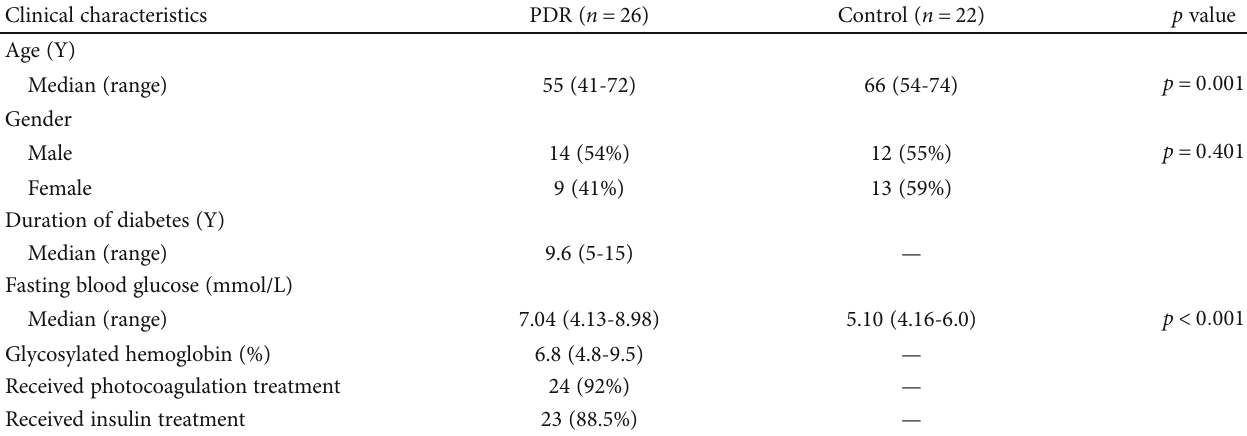
Table 1: Clinical characteristics of the study